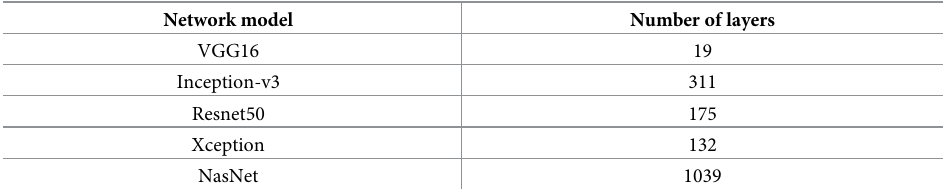
Table 1. The depth of the network model.